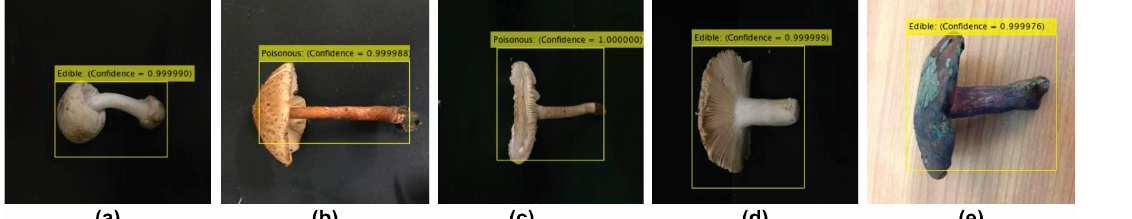
Figure 15. The object detection prediction results: ( a ) Amanita citrina; ( b ) Inocybe rimosa; ( c ) Ama- nita phalloides; ( d ) Russula delica; ( e ) Phaeogyroporus portentosus.